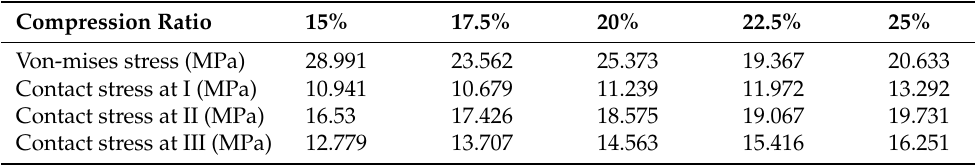
Table 2. Contact stress and compression ratio (working pressure 10 MPa).